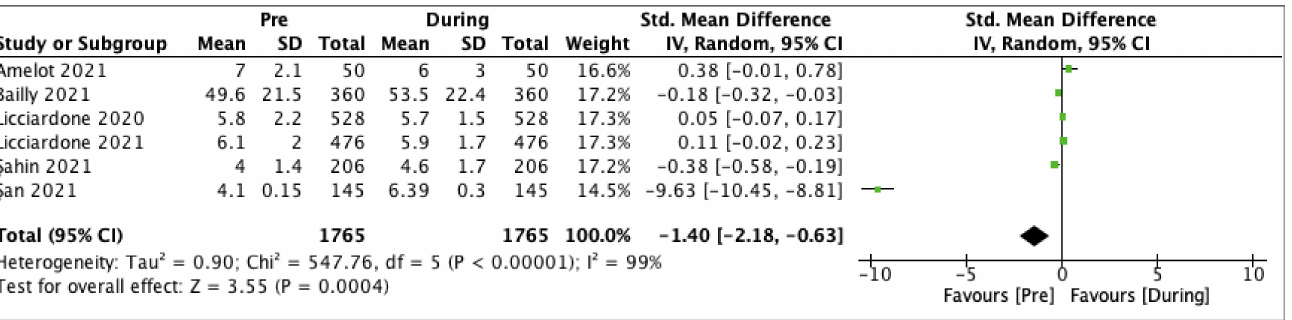
Figure 3. Low back pain intensity. Before versus during the pandemic